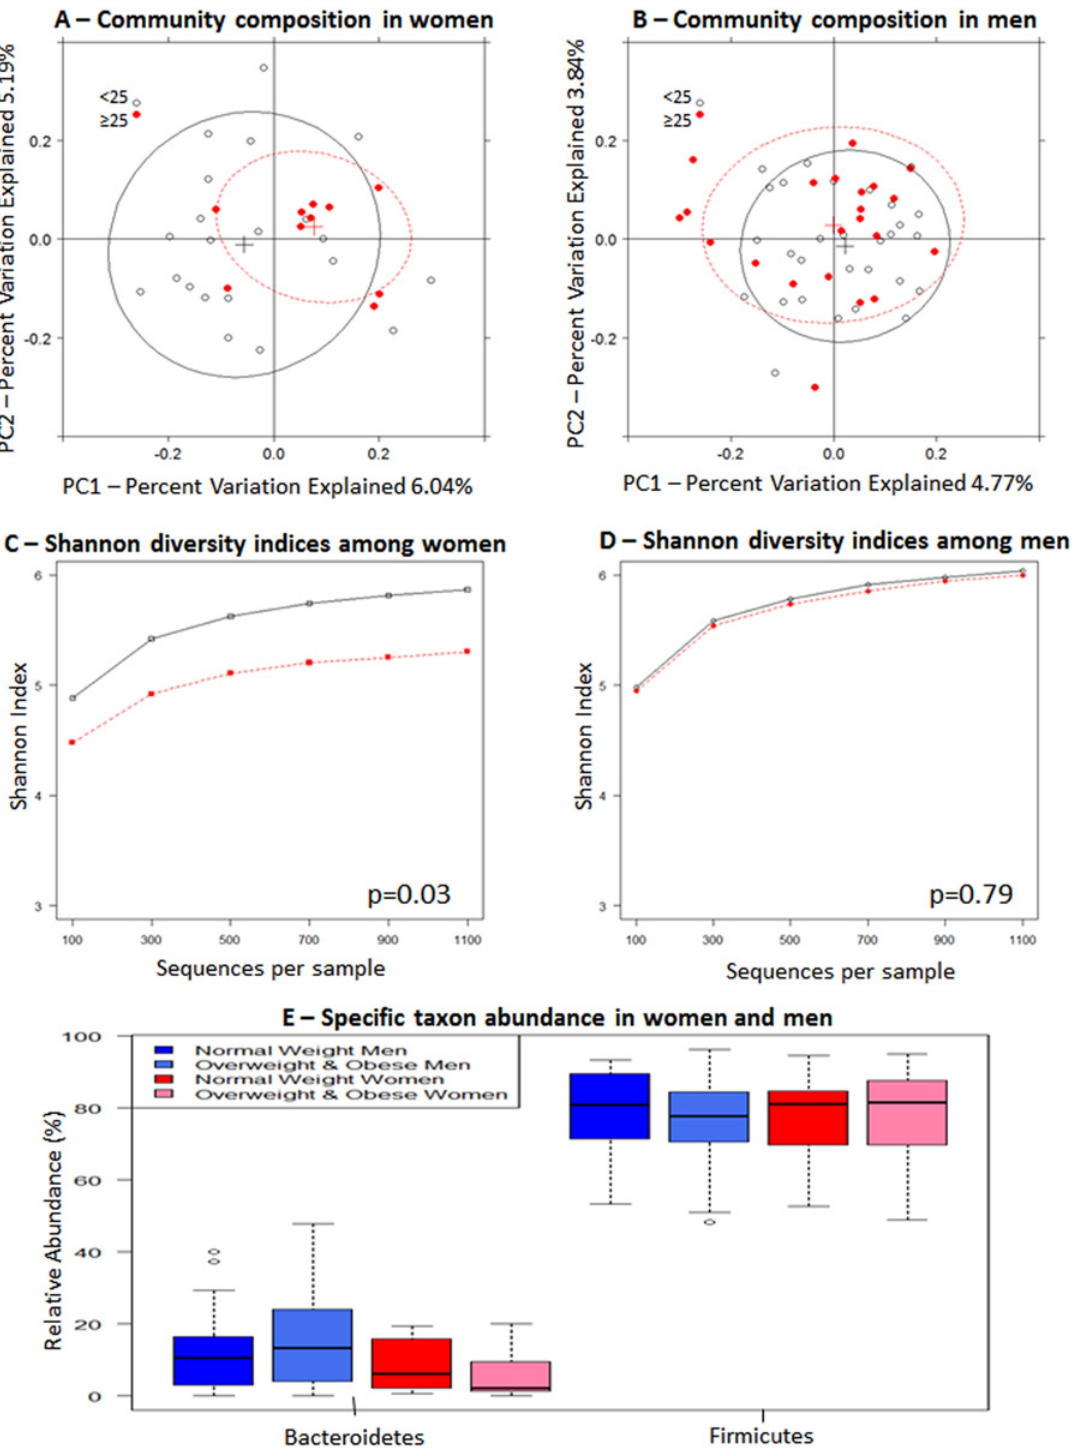
Fig 3. Gut microbiome according to BMI in women and men separately. Unweighted principal coordinate analysis plot of the first two principal coordinates categorized by BMI ( < 25 kg/m 2 , (cid:3) 25 kg/m 2 ) in (A) women and (B) men. Ellipses were added to plots using the R package, latticeExtra (R version 2.15.3). Alpha rarefaction plots of Shannon diversity indices grouped by normal weight ( < 25 kg/m 2 ; open circles) and overweight/obese ( (cid:3) 25 kg/m 2 ; red circles) status for women (C) and for men (D). Statistical significance was assessed by non-parametric Monte Carlo permutations (QIIME). (E) Relative abundance of Firmicures and Bacteroidetes. Mann-Whitney-Wilcoxon test was used to test for overall differences using SAS software (version 9.3).